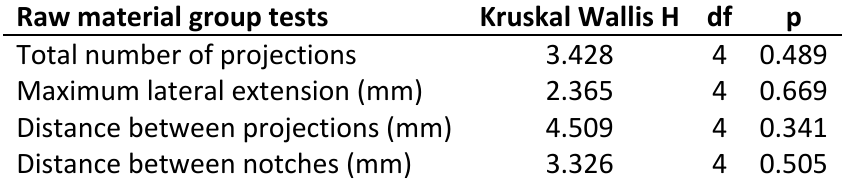
Table 12. Kruskal Wallis tests for raw material groups and projection metrics.